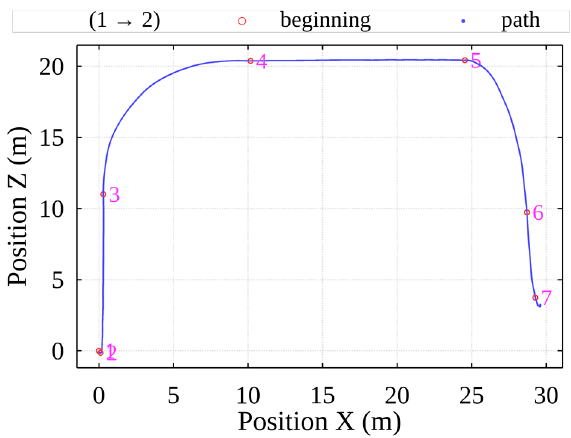
Figure 7. Container transportation path from ship to truck.